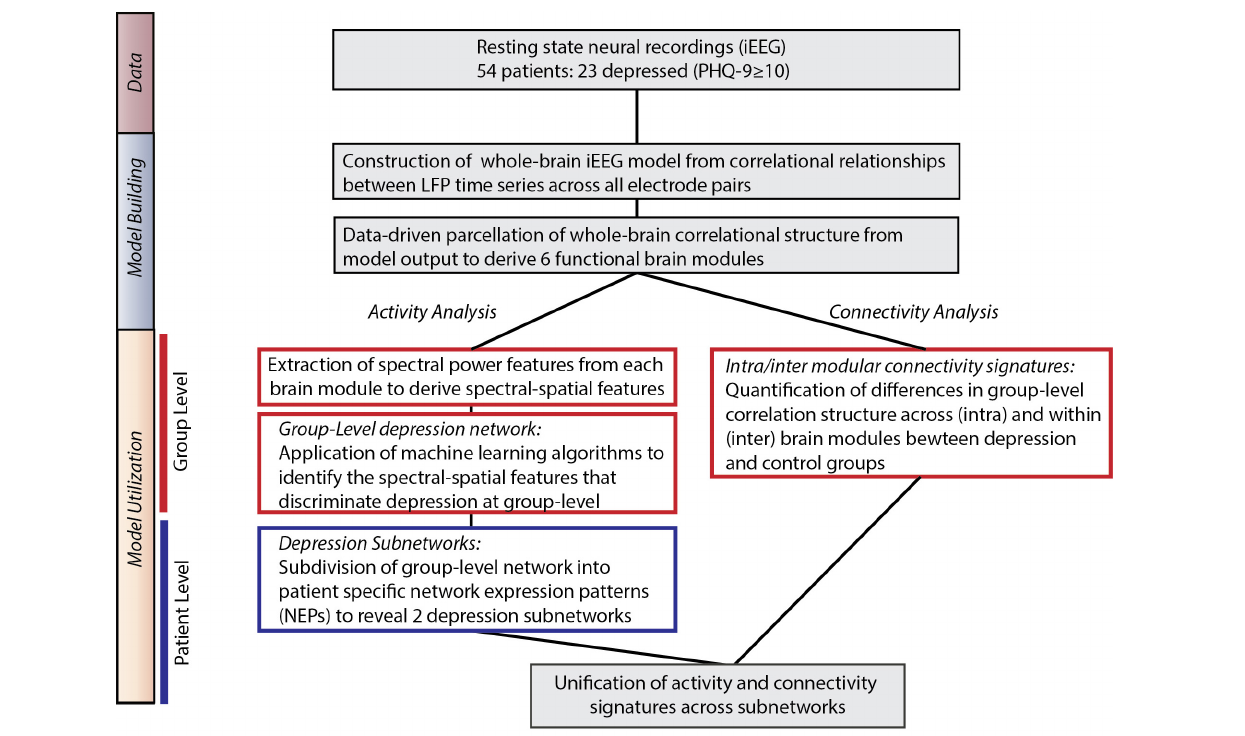
FIGURE 1 | Overall approach. Model Building: We utilized direct neural recordings from 54 patients to construct a whole-brain model of iEEG activity based on correlational relationships of neural LFP time series signals across all electrode pairs. We then parcellated this model into functional network modules using graph theory metrics. Model Utilization: We used the whole-brain iEEG model to study how brain activity and connectivity measures relate to depression status. We first defined spectral power features across network modules and applied supervised machine learning to identify a group-level network features of depression ( Activity analysis ). In parallel, we identified alterations in functional network connectivity and organization between depressed and control groups ( Connectivity analysis ). Common group-level network features expressed at the individual level were clustered to identify two distinct patterns of altered activity and